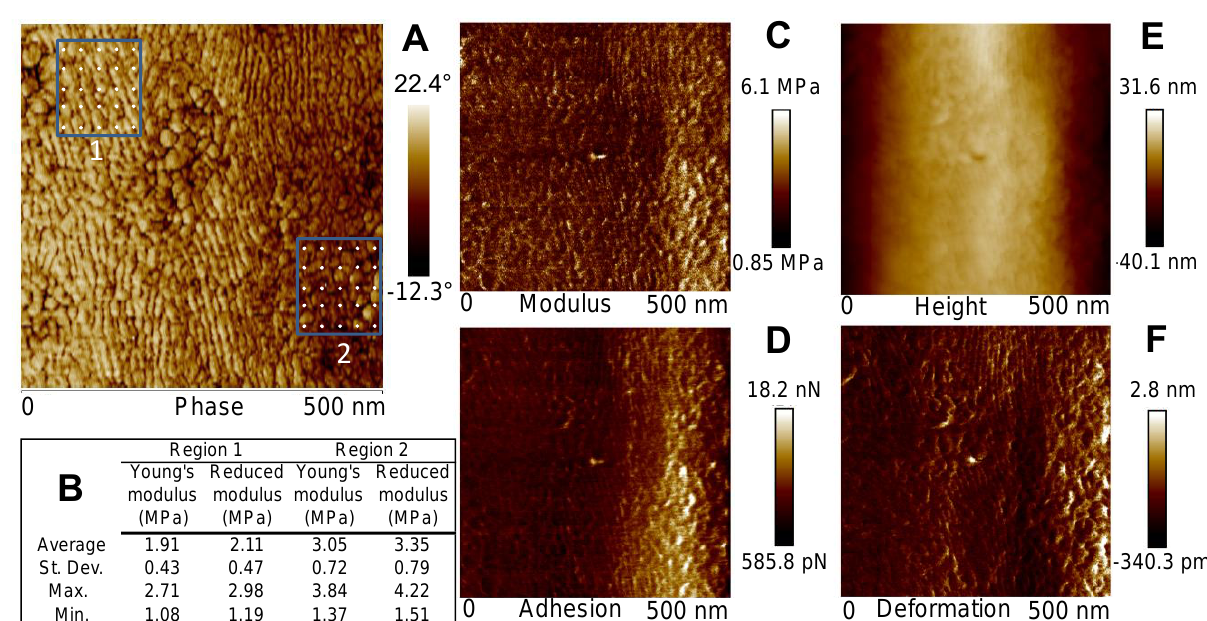
Figure 3. Results of quantitative nanomechanical (QNM) and tapping mode (TM) AFM imaging along a 500 × 500 nm area of an unstretched silk thread from Arachnocampa tasmaniensis . QNM was conducted in a 5 × 5 grid pattern in two distinct regions of the thread sample previously mapped through TM – AFM ( A ) and showed differences in modulus values ( B ). Other QNM channels (adhesion, modulus, deformation) also show differences between regions ( C – F ).